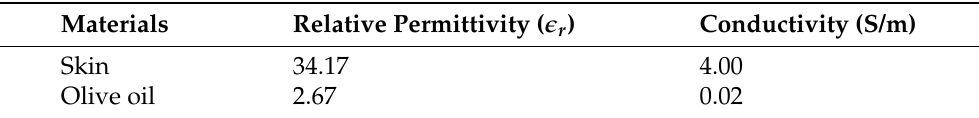
Table 3. The relative permittivity and conductivity of skin and olive oil in double-layered configura- tion for sensing depth experiment at 4